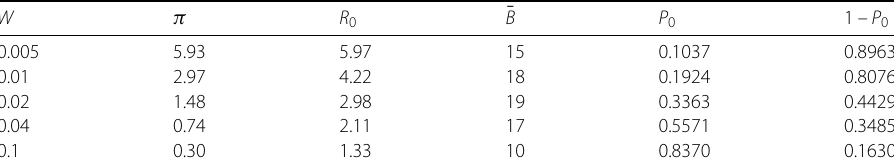
Table 5 Variation of endemic indicators for different values of the pregnancy rate W . Parameter values are given in Table 3, with the exception of W , which varies over the indicated range. The initial conditions used to calculate P 0 are I h (0) = 1, I p (0) = 0, and I v (0) = 0. W π R 0 ¯ B P 0 1 – P